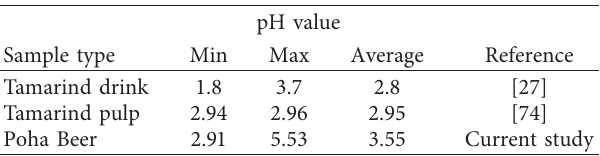
Figure 6: Average zonal pH values. Table 4: Compared pH values of tamarind and tamarind drinks obtained in the literature.